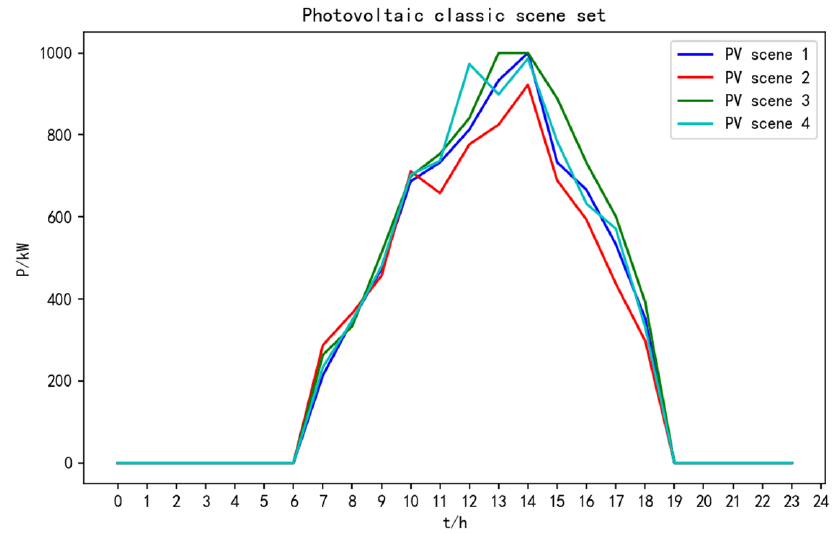
Figure 8. Photovoltaic output scenario generated by fuzzy clustering algorithm.